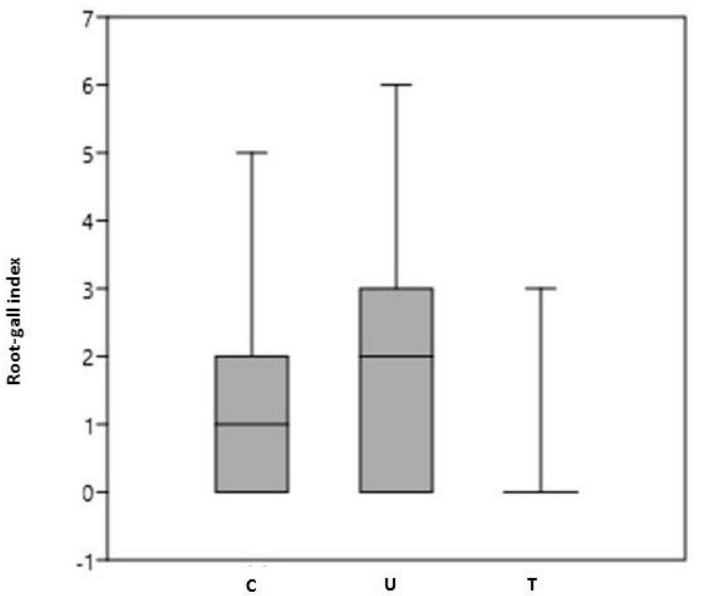
Figure 4. Influence of the managements (Uncultivated: U, Control: C, and Treated: T) on root- gall